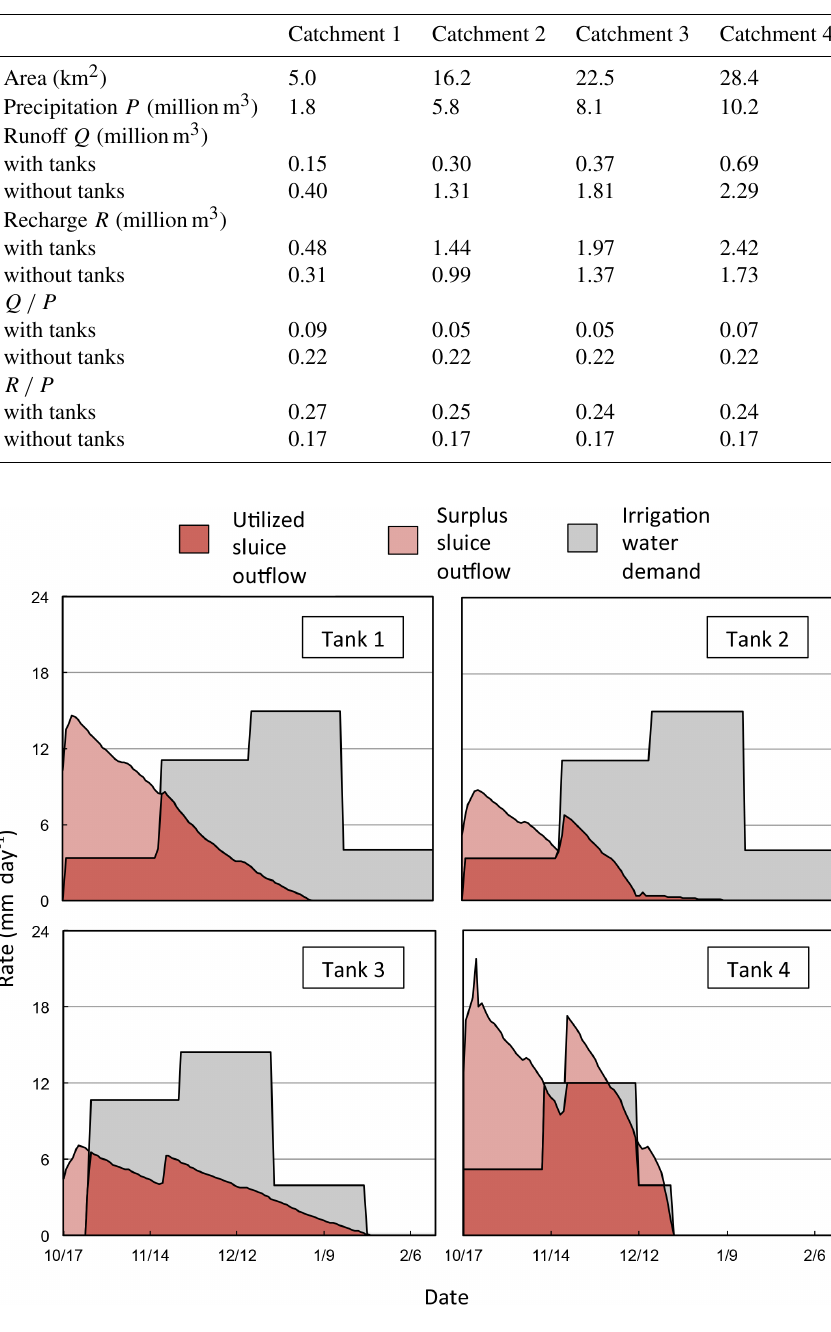
Figure 11. Water supply-and-demand portraits in our tank cascade. The grey area represents the irrigation water demand (IWD), calculated as the difference between crop water requirements and rainfall (Brouwer et al., 1989). Planting dates were 17 October, 17 October, 25 September, and 13 September, for Tanks 1, 2, 3, and 4, respectively. The darker red area corresponds to the portion of sluice outflow that is utilized to meet the irrigation water demand, while the light red area corresponds to the portion of sluice outflow that is not directly utilized by crops in the tank’s command